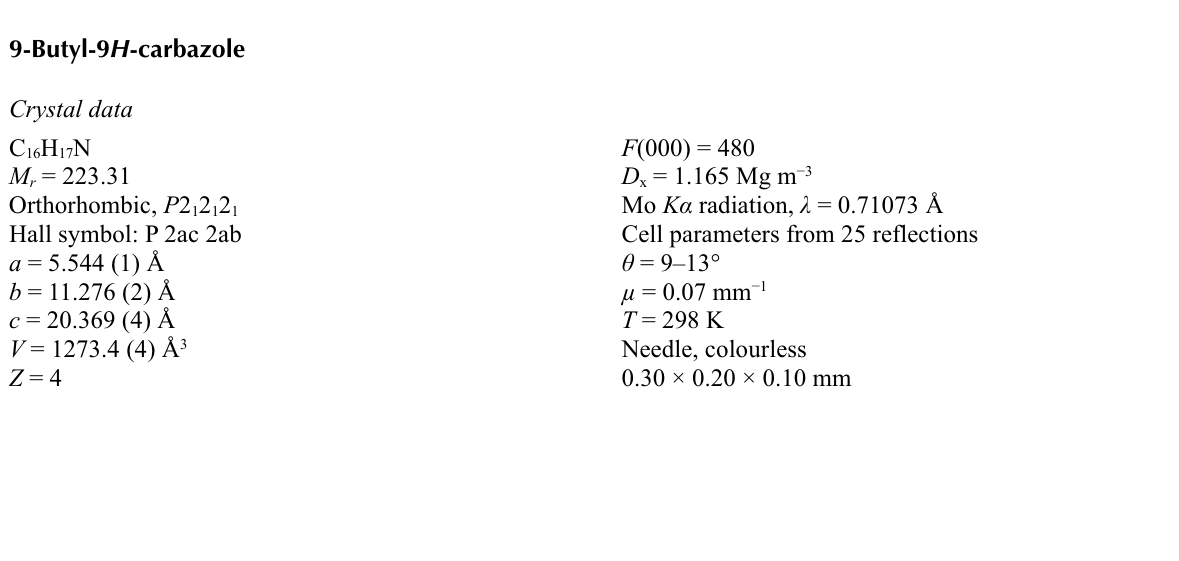
The molecular structure of (I), showing the atom-numbering scheme. Displacement ellipsoids are drawn at the 50% probability